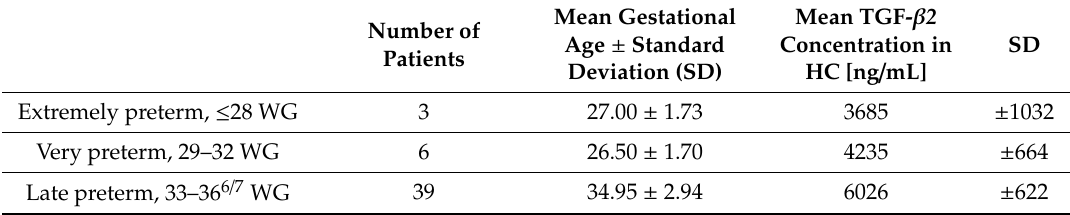
Table 2. Transforming growth factor β (TGF- β 2) concentration in human colostrum (HC) after preterm delivery according to weeks of gestation (WG).